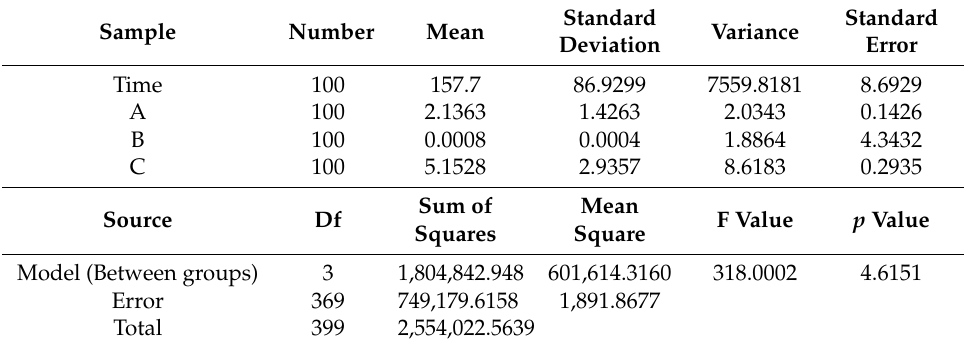
Table 2. One-way ANOVA for statistical evaluation of the influence of the burner’s position on the burning rate (weight loss) of the sample when Eco-panels in groups A, B, and C were exposed to a